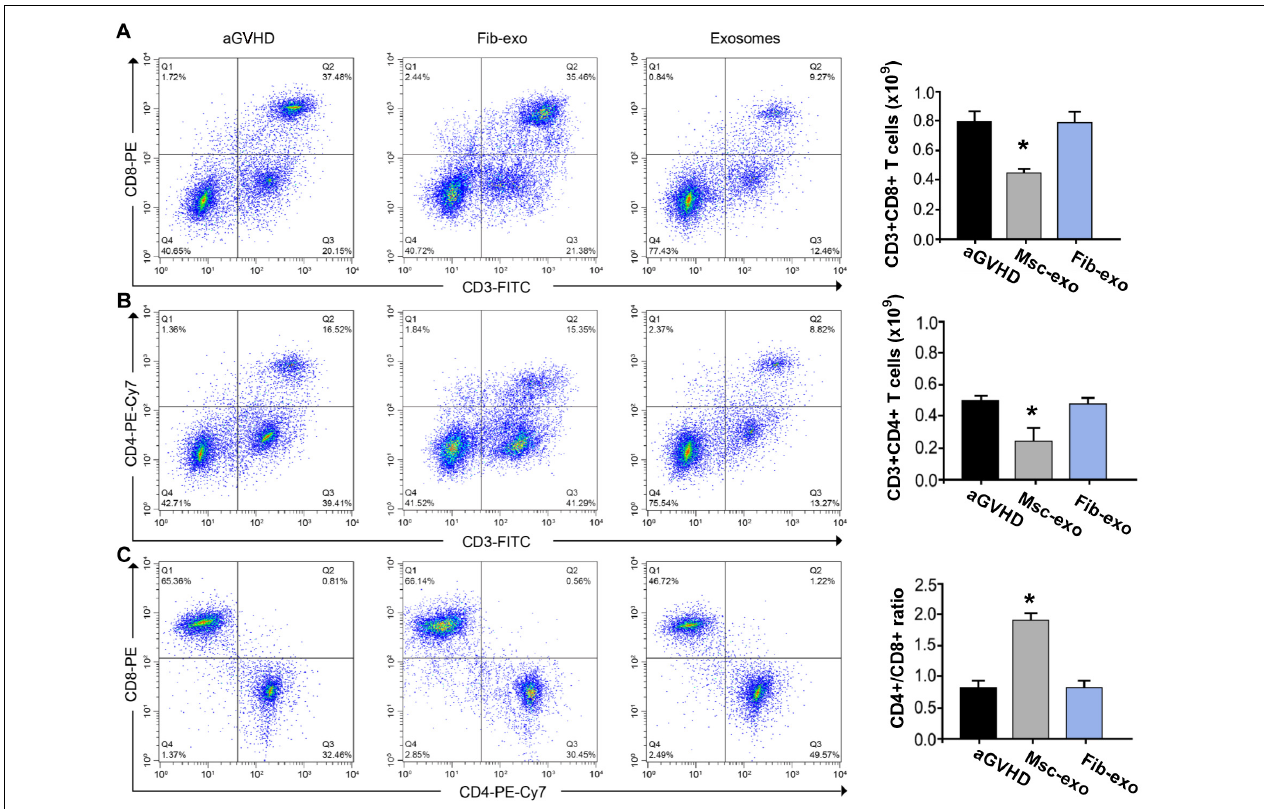
FIGURE 3 | Human bone marrow–derived mesenchymal stem cell (hBMSC)–derived exosomes altered T-cell subpopulation in acute graft-versus-host disease. (A) The number of CD3 + CD8 + T cells of blood samples in the control and Msc-exo treated mice. (B) The number of CD3 + CD4 + T cells of blood samples in the control and Msc-exo treated mice. (C) The ratio of CD4 + to CD8 + T cells in the control and Msc-exo treated mice. * p < 0.05. Data were representative of two to three independent experiments where n = 5 in each